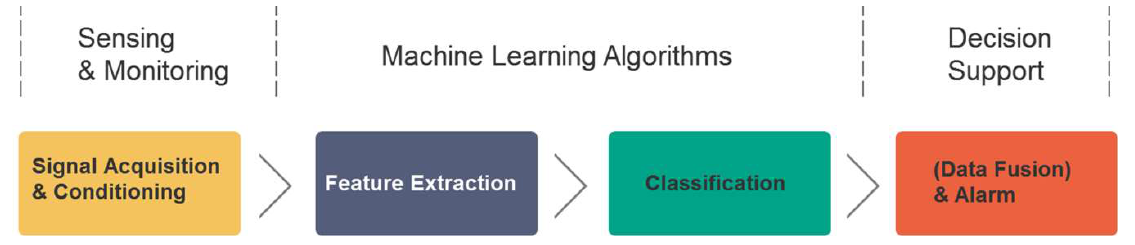
Figure 3. Automatic seizure monitoring by machine learning techniques.